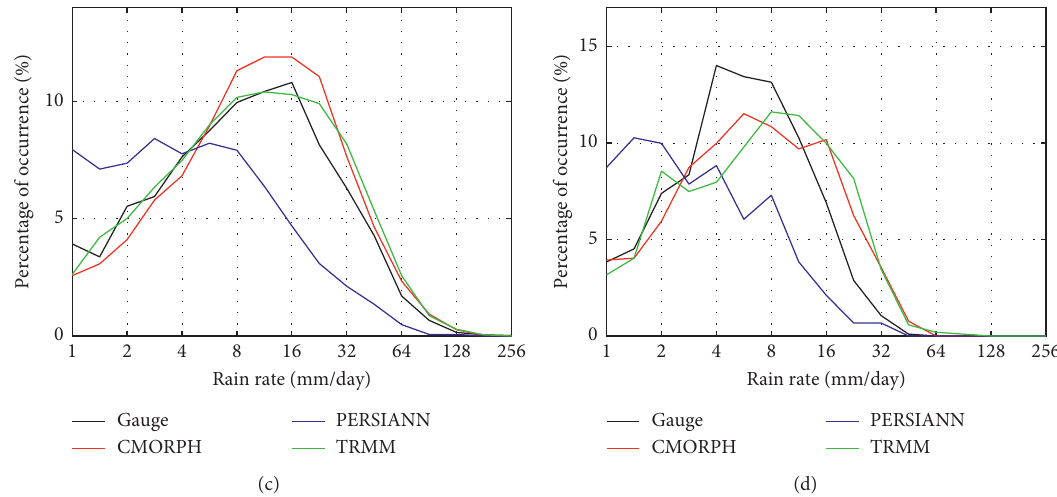
Figure 16: The percentage of rainfall occurrence in (a) spring, (b) summer, (c) autumn, and (d) winter in the Three Gorges Reservoir area.